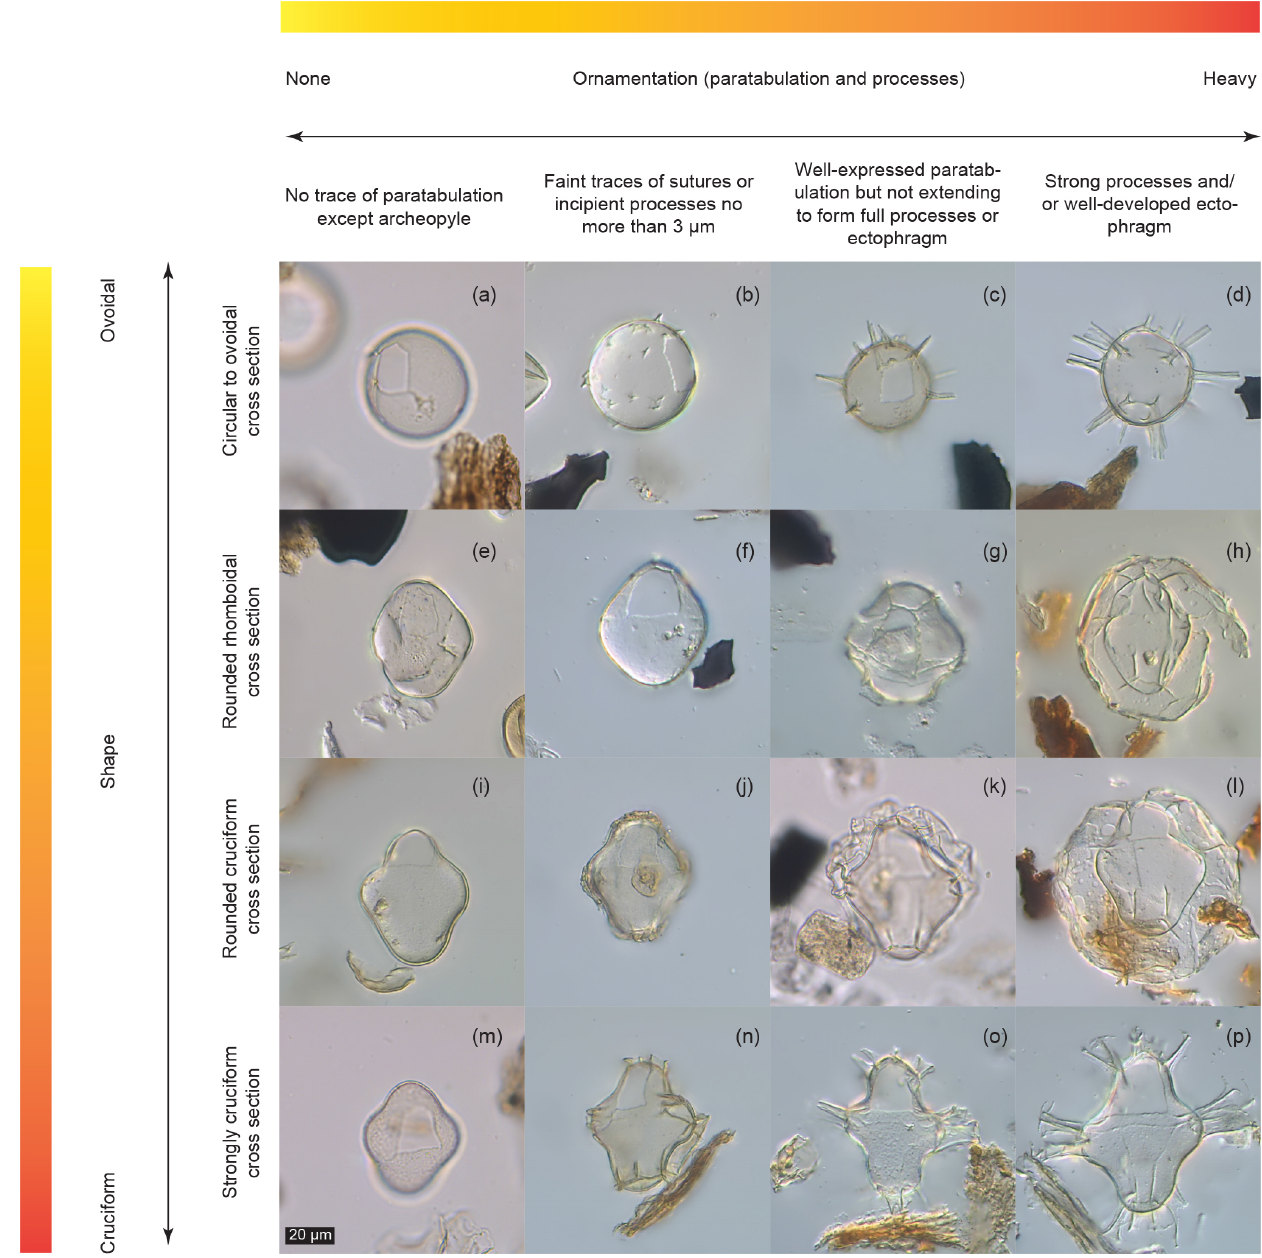
Figure 3. Dinocyst variability matrix showing continua between described forms. Sample codes give core number (first number), section number (second number), depth within core (third number, in centimetres) and depth of the middle of the sample in metres below sea floor (mb.s.f.). (a) Pyxidinopsis psilata (6-R-1-W, 3–5.5cm, 45.54mb.s.f.). (b) “ Pyxidinopsis psilata ? var. A” (21-R-6-W, 20–23, 195.56mb.s.f.). (c) Dinocyst C (29-R-1-W, 41–44cm, 263.93mb.s.f.). (d) Dinocyst D (29-R-1-W, 41–44cm, 263.93mb.s.f.). (e) Pyxidinopsis psilata